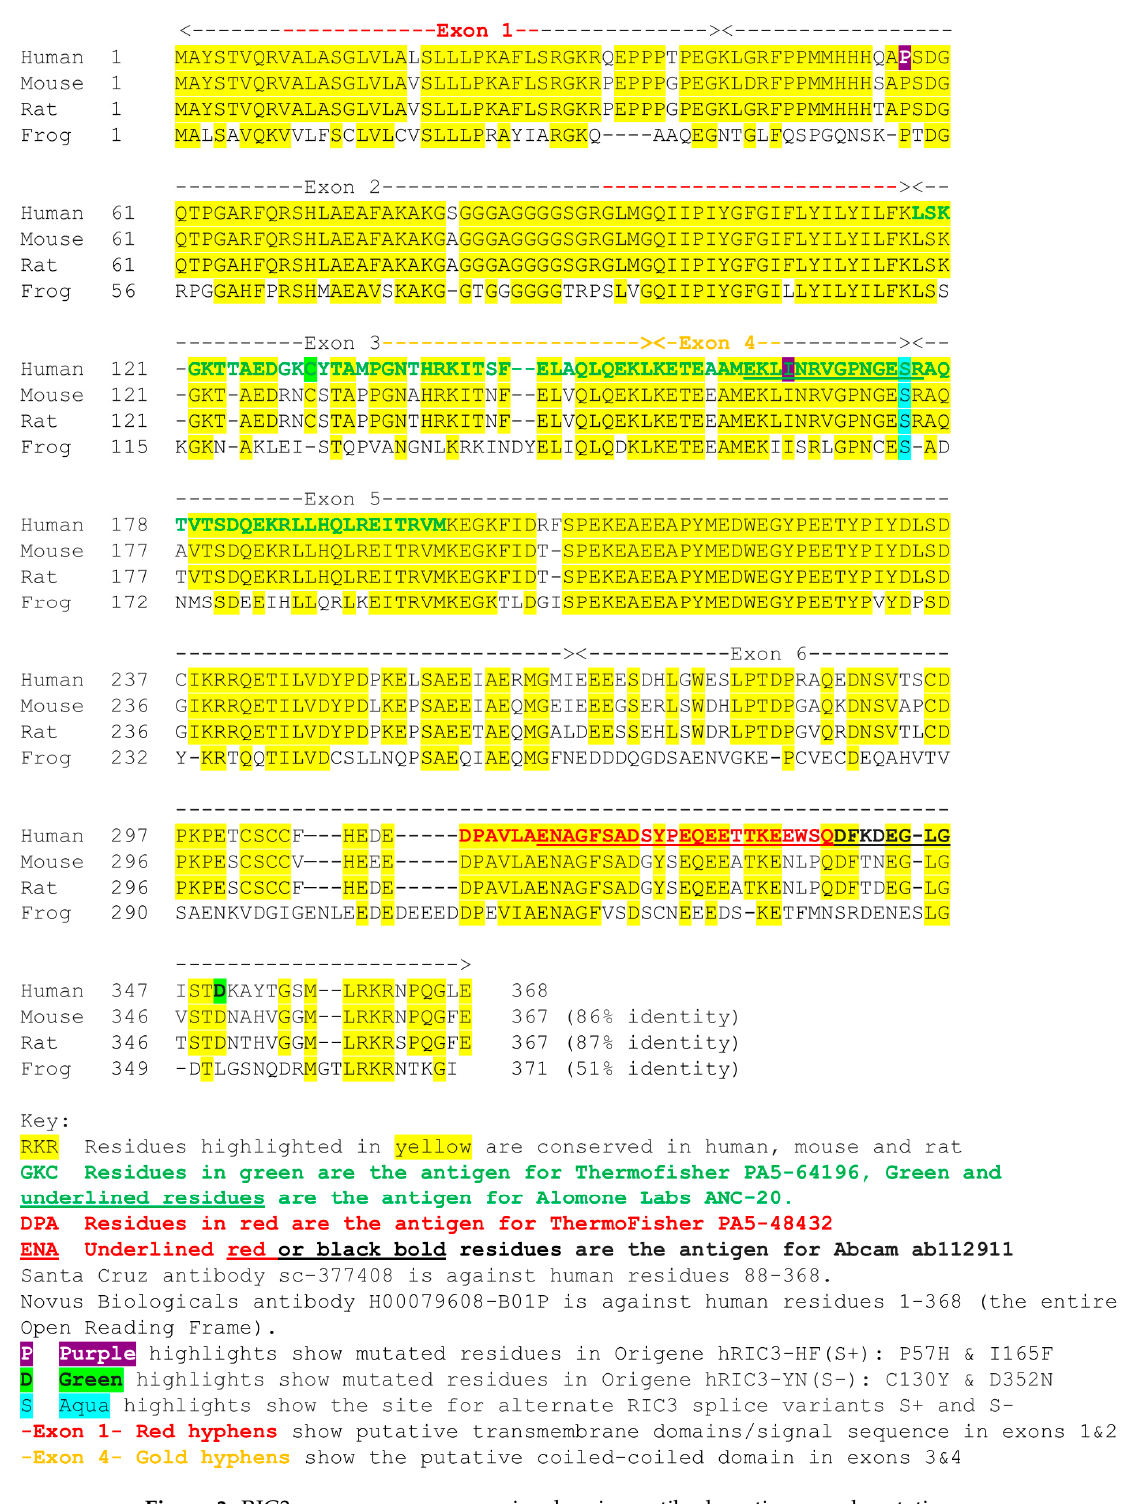
Figure 3. RIC3 sequences across species showing antibody antigens and mutations.